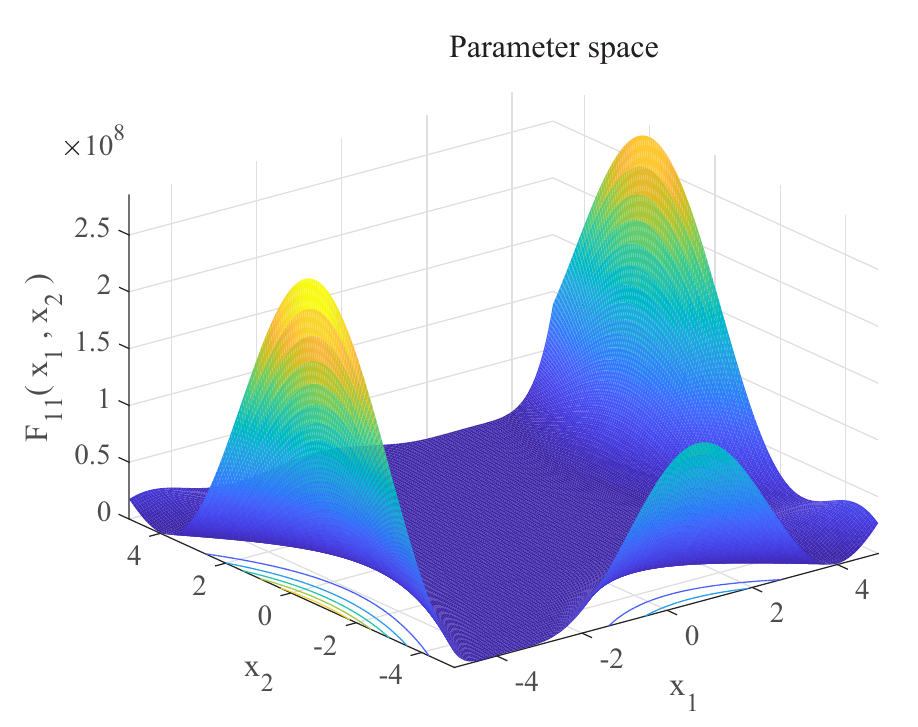
Fig 12. Three-dimensional graph of F 11 ( x